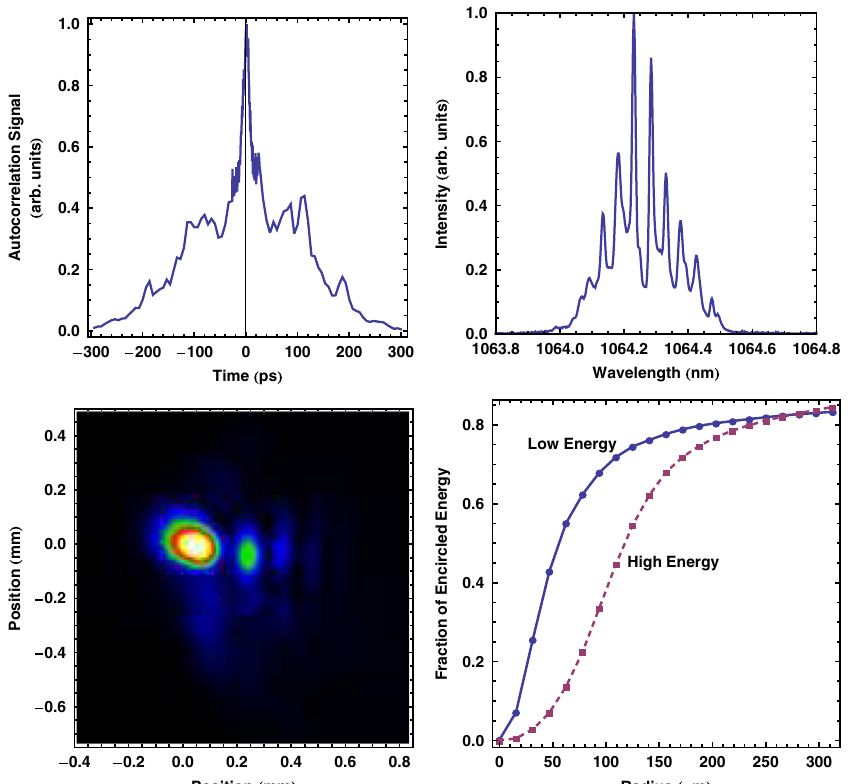
FIG. 6. (Color) Top left: Autocorrelation trace of the compressed ILS IR pulse. Approximately 20% of the energy is in the central peak. Top right: Spectrum of the compressed ILS IR pulse. Bottom left: Profile of the ILS focal spot after an f ¼ 2 : 4 m lens. Bottom right: Fraction of total energy contained within an aperture of a given radius for low- and high-energy system